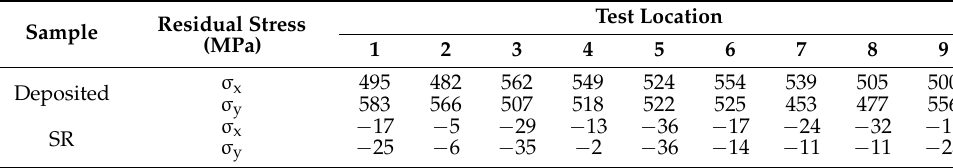
Table 8. Residual stress of different treated